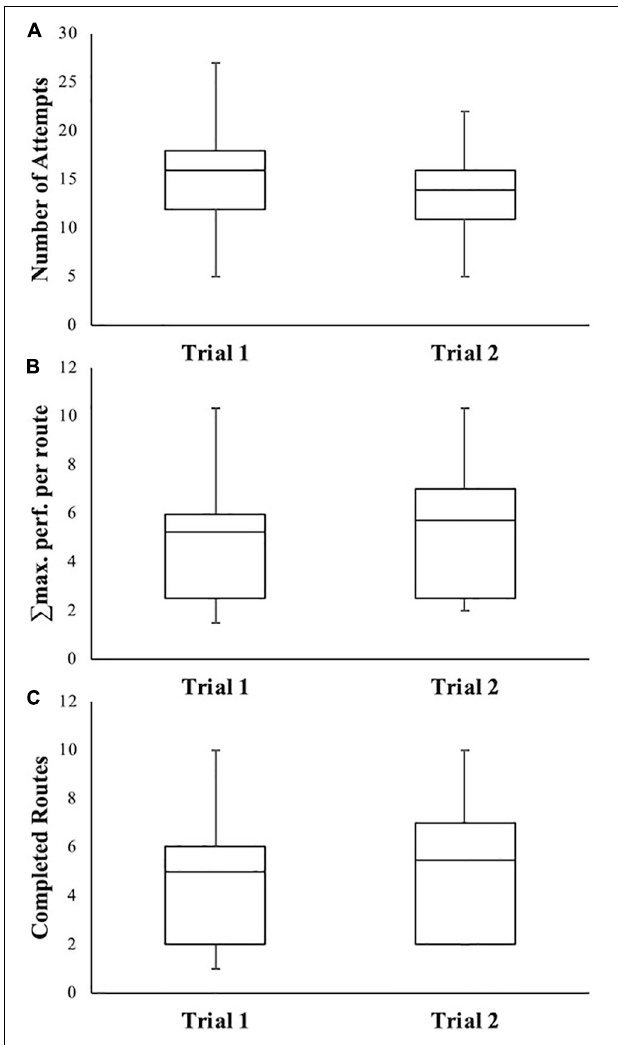
FIGURE 3 | Boxplots depicting the medians, quartiles, minimum, and maximum of the number of attempts (A) , accumulated maximum performance (B) , and number of routes completed (C) for each trial.